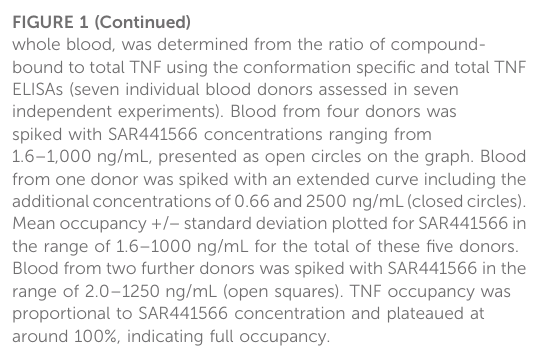
TABLE 1 Af fi nity of SAR441566 binding to human